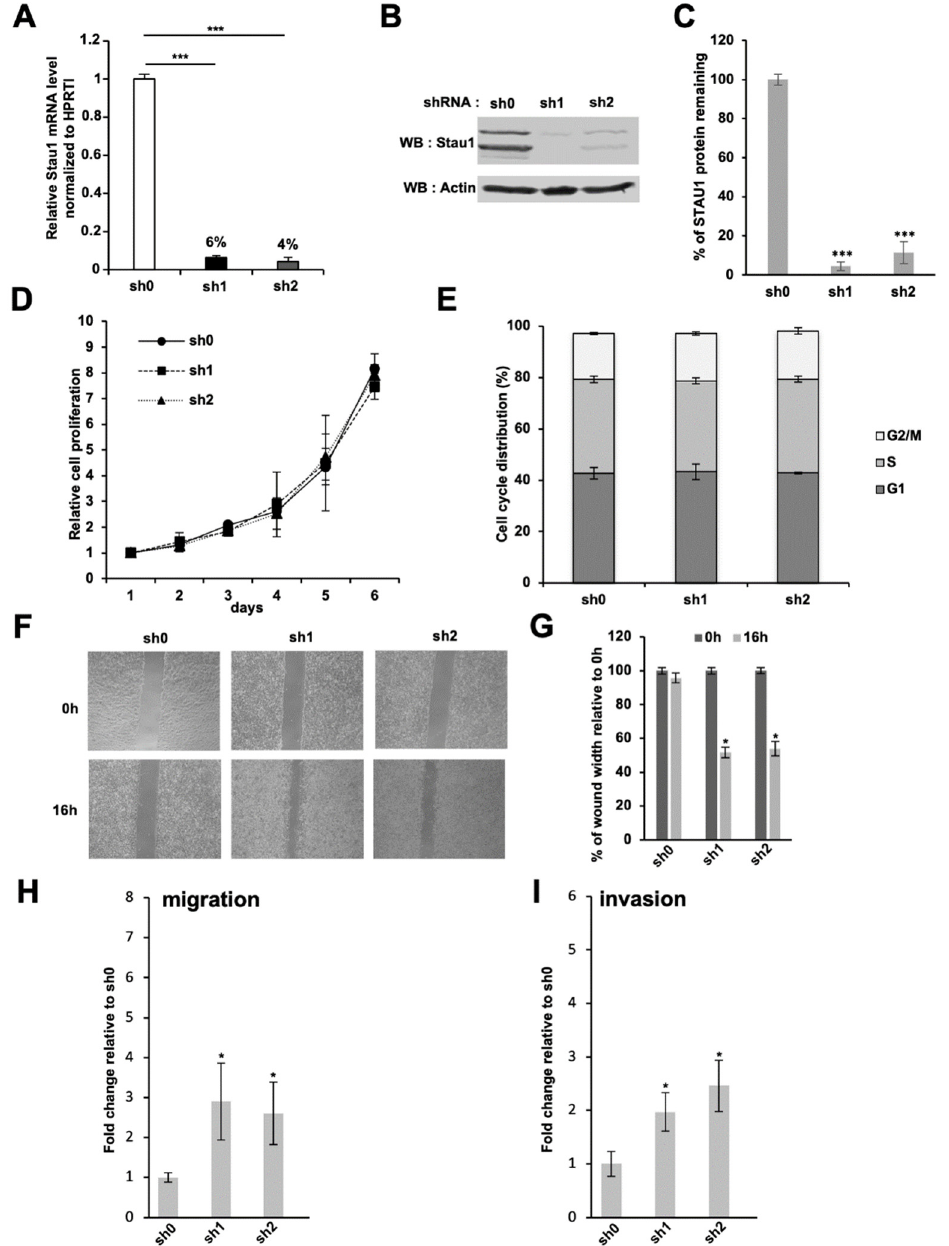
Figure 2. Effect of Stau1 knock-down in the H460 lung carcinoma cell line. ( A ) H460 cells were transduced by lentivectors expressing the indicated shRNA: sh0 has no target sequence in the human genome; sh1 and sh2 are two different shRNAs targeting the Stau1 coding sequence reducing Stau1 mRNA level by 94 and 96%, respectively. ( B ) Western blot analysis revealed that Stau1 protein levels are strongly impaired in sh1 and sh2 H460 cells compared to Stau1 sh0 control cell line. ( C ) Densitometry analysis on Stau1 protein remaining level relative to the sh0 control cell line was performed on 3 independent experiments and statistical analysis applied. ( D ) Cell proliferation analysis of the three indicated cell lines. ( E ) Cell cycle analysis at day 5. Stau1 depletion does not interfere with cell cycle progression in H460 cells. ( F ) Representative pictures of a wound healing assay performed on sh0, sh1 and sh2 cell lines after 16 h. ( G ) Quantification of ( F ). Stau1 depletion increases cell motility significantly. ( H , I ) Transwell assays were performed in Boyden chamber without ( H ) or with ( I ) Matrigel TM coating to analyze the impacts of Stau1 depletion on the invasion and migration of lung cancer cells. Fold change relative to the sh0 control is shown. (Asterisks: * p < 0.05; and *** p < 0.001 in two-tailed Student’s t-test).